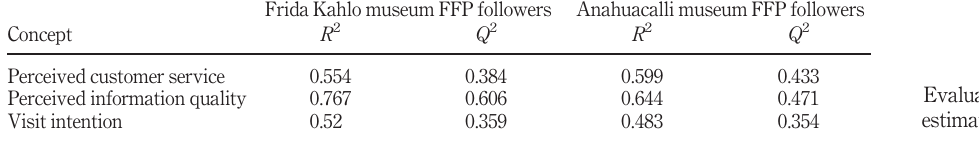
Table V. Evaluation of the estimated